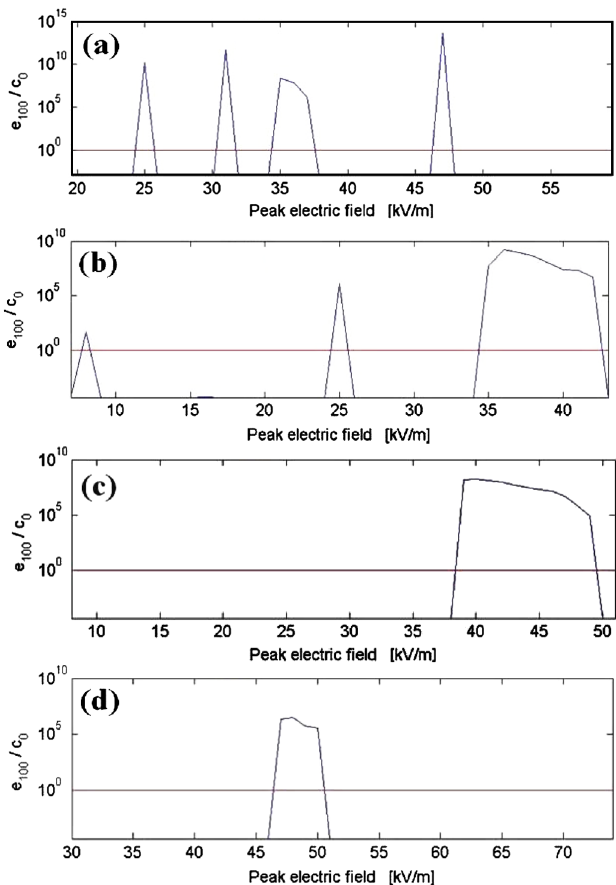
FIG. 6. (Color) (a) Enhanced counter function plot for 20–40 cm of the cavity. Multipacting is probable at peak surface electric field 25, 31, 35–37, and 47 kV = m . (b) Enhanced counter func- tion plot for 40–60 cm of the cavity showing probable multi- pacting electric field at 25 and 36 – 44 kV = m . (c) Enhanced counter function plot for 60–80 cm of the cavity. Multipacting is probable in the band of 38 – 49 kV = m . (d) Enhanced counter function plot for 80–100 cm of the cavity showing multipacting probable band at 47 – 50 kV = m